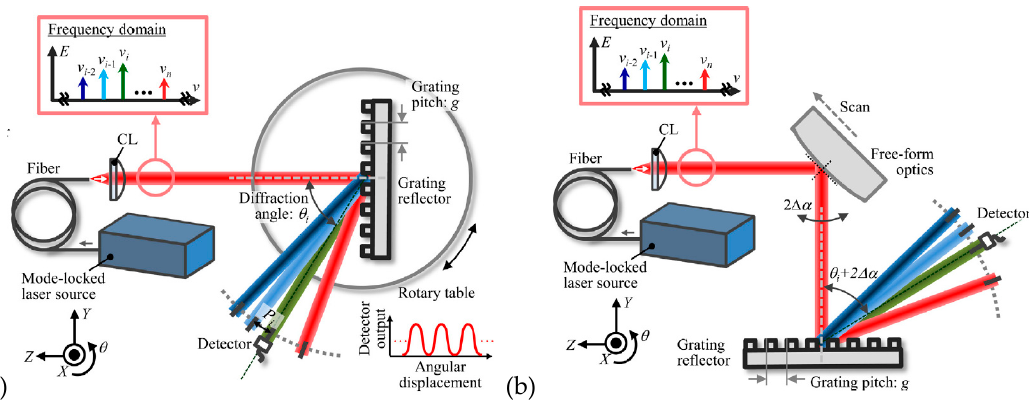
Figure 2. Applications of the angle scale comb [54]: ( a ) Measurement of the angular displacement of a rotary table; ( b ) Measurement of the surface form of an optical component.